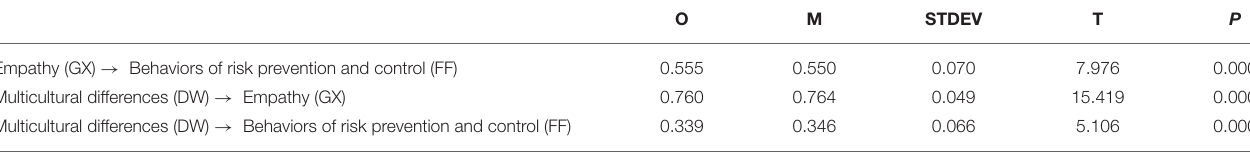
TABLE 6 | Significance test results of path coefficients.